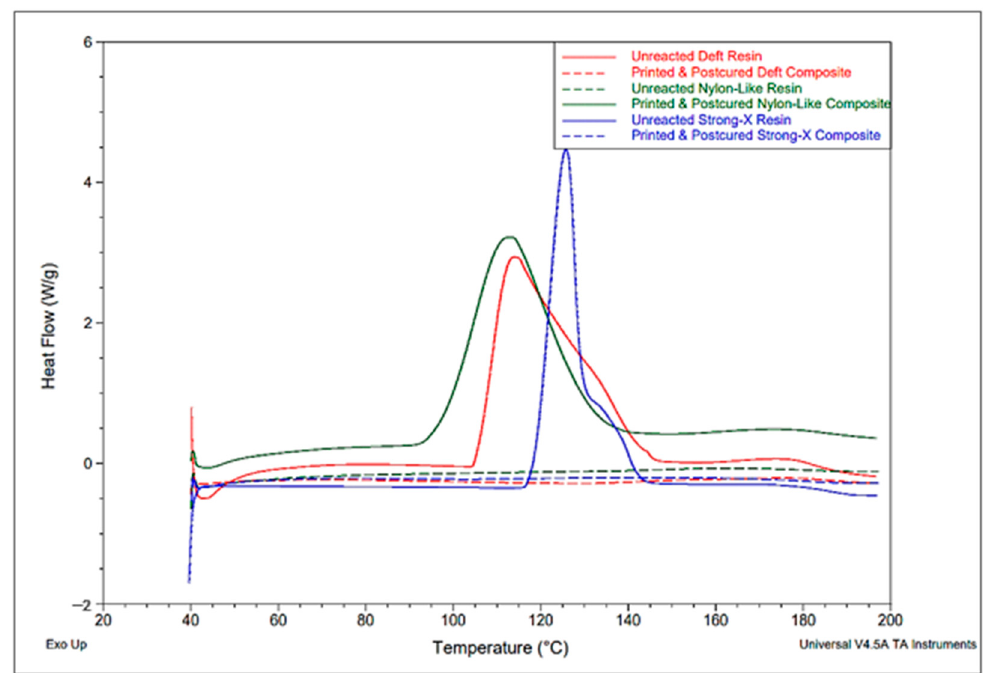
Figure 3. Heat flow curves of unreacted resins and post-cured composites during DSC tests.